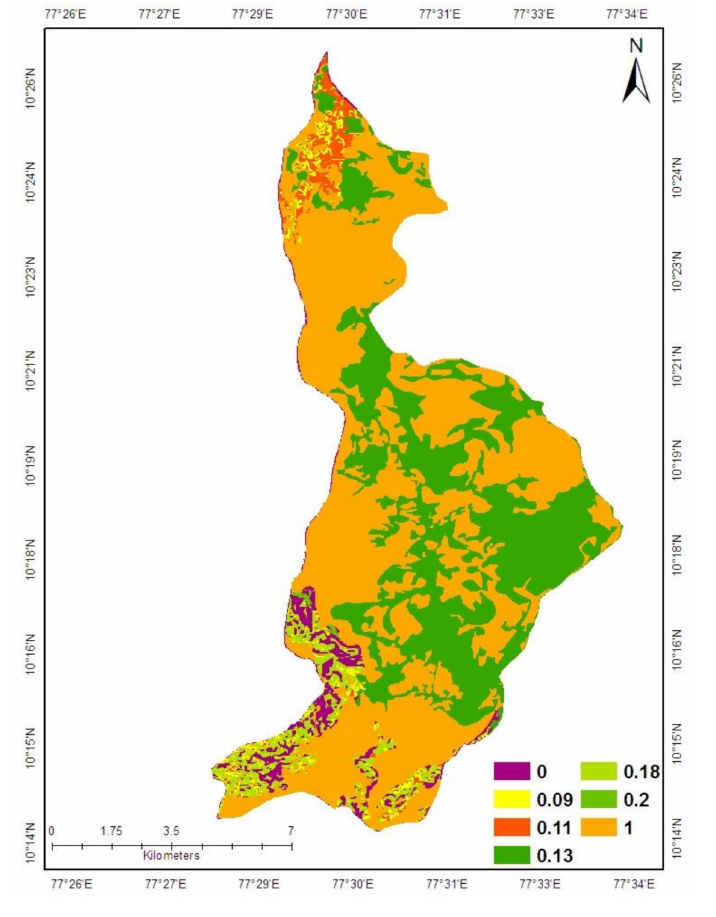
Figure 6. Conservation support practice factor (P). Table 2. Adopted P factor values (after Schwab et al. [37] and modified based on field